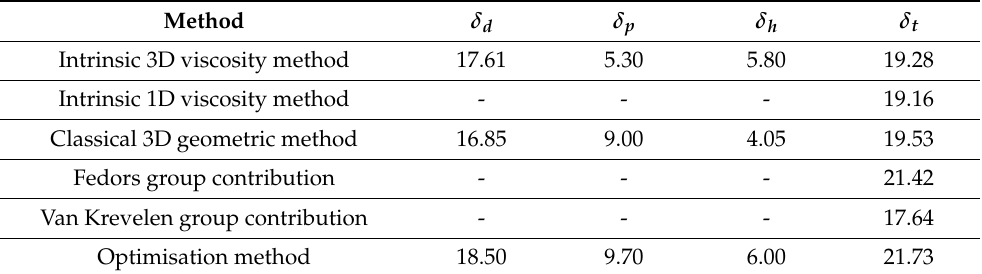
Table 12. Solubility parameters for PLA using an appropriate method at 25 ◦ C